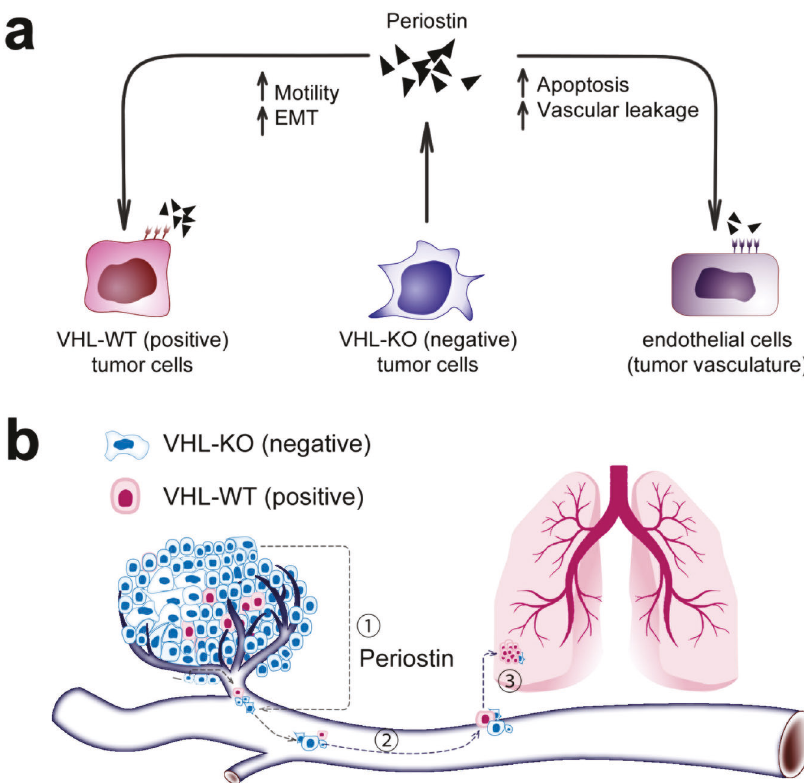
Fig. 7 Paracrine action of POSTN in the collaborative metastasis model between VHL- and VHL + cells. a A summary of the pro-metastatic paracrine functions mediated by POSTN. b The cooperative metastatic mechanism uncovered paracrine-promoting interactions between VHL- KO and VHL-WT cells, mediated by POSTN, at the tumor proper and the intravasation step (1) of the metastatic cascade. The potential impact of the cooperative metastatic mechanism on downstream steps of the cascade, such as cell survival in the circulation (step 2), and